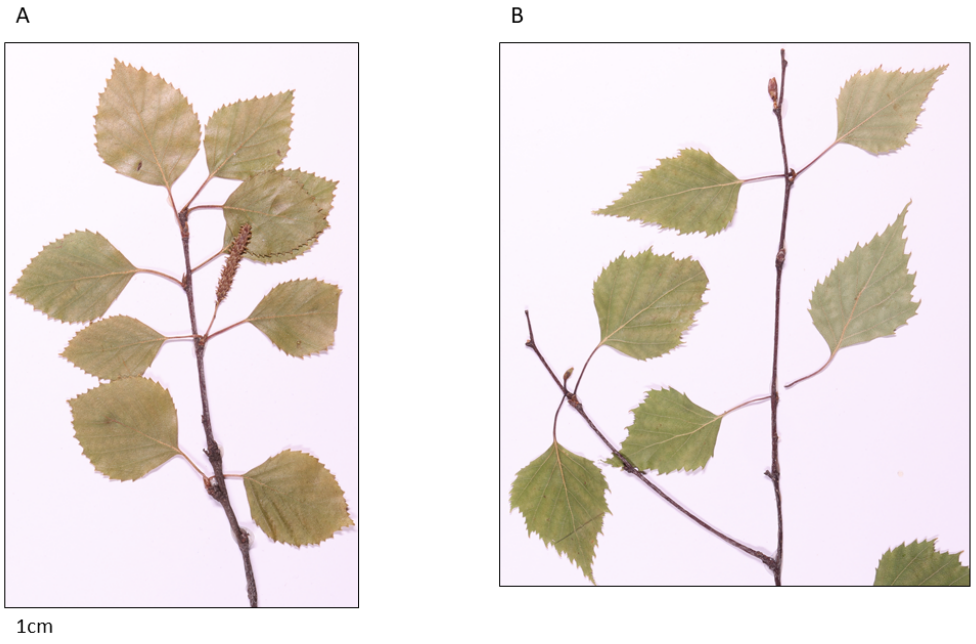
Figure 1. Photographs of the two species under study. ( A ) Betula pubescens is distinguished by having downy young twigs and more triangular-oval leaves, whereas ( B ) B. pendula tends to be glabrous with prominent raised glands on young twigs and a more pointed triangular leaf shape.